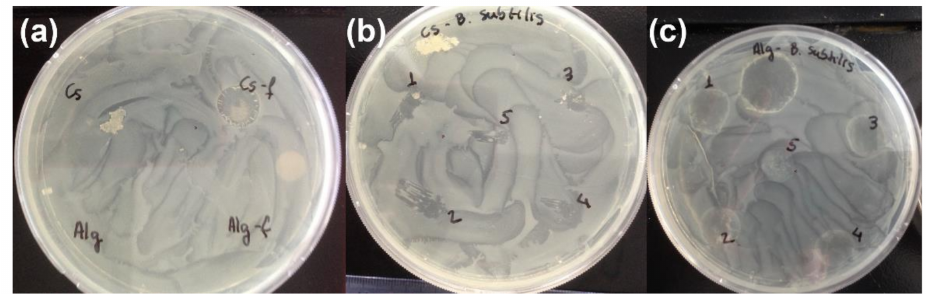
Figure A4. Photographs of biological resistance tests of ( a ) freeze-dried and air-dried chitosan and alginate against E. coli , ( b ) freeze-dried chitosan and ( c ) freeze-dried alginate against B. subtilis